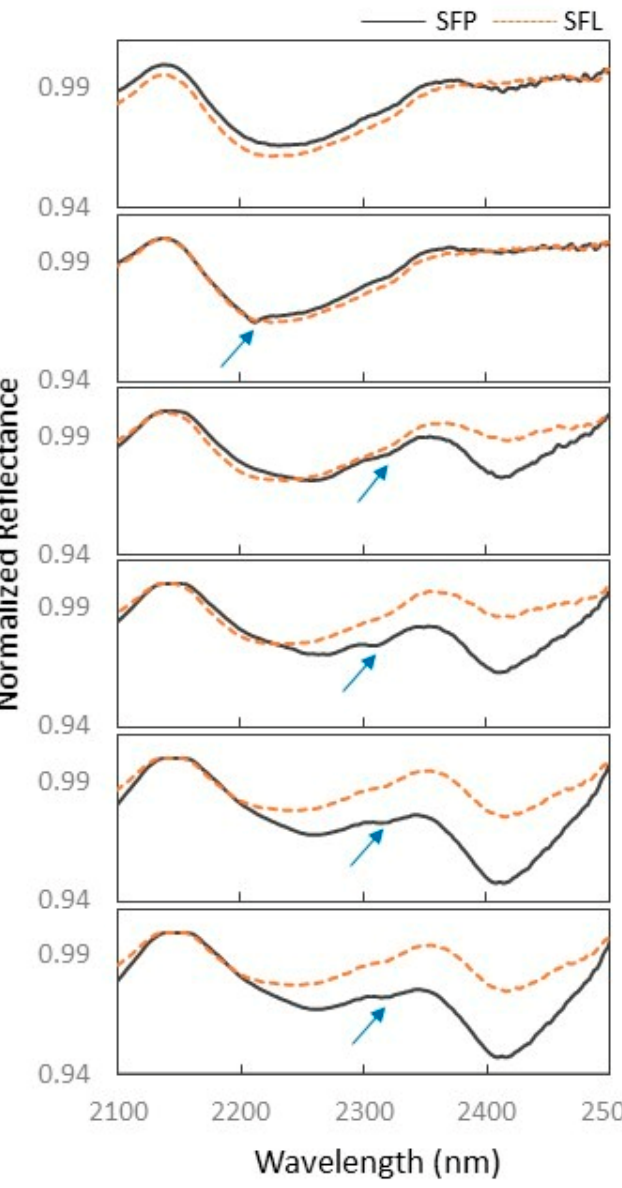
Figure 6. Reflectance spectra normalized by removing the continuum of sinter feed product (SFP) samples and their equivalent prepared in the laboratory (SFL). The figure shows in detail the absorption features in the SWIR region that occur mainly for SFP.